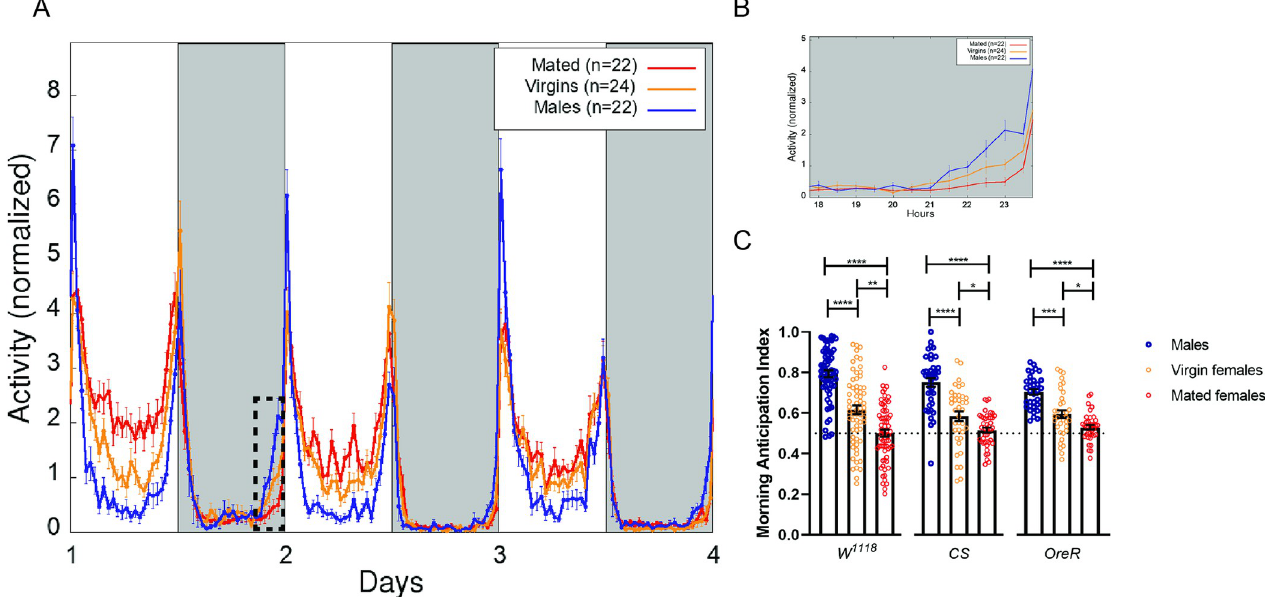
Fig 1. Mating suppresses morning anticipation in females of Drosophila melanogaster . (A) Average locomotor activity profile of white (w 1118 ) flies in LD. The number in the horizontal axes refers to days after males were removed. ( B) Zoom of the region enclosed by dashed lines in panel A to highlight the increase of the locomotor activity at the end of the night. (C) Anticipation indexes for males (blue), virgin (orange) and mated (red) females of white , CantonS and Oregon flies. For w 1118 flies: males (n = 62), virgin females (n = 64) and mated females (n = 66). For CS flies: males (n = 39), virgin females (n = 37) and mated females (n = 43) and for Oregon flies: males (n = 34), virgin females (n = 35) and mated females (n = 37). Each dot corresponds to the average index of three complete days calculated for a single fly. The mean and SEM are shown as bars. Statistical analysis: Kruskal–Wallis test; for the MAI of white flies, X 2 = 78.02, p < 0.0001; for the MAI of CS flies, X 2 = 49.48, p < 0.0001; for the MAI of OreR flies, X 2 = 44.43, p < 0.0001. Pairwise comparisons were performed using Dunn’s multiple comparisons test. Statistically significant differences are represented by � p < 0.05, �� p < 0.01, ��� p < 0.001, ���� p < 0.0001.